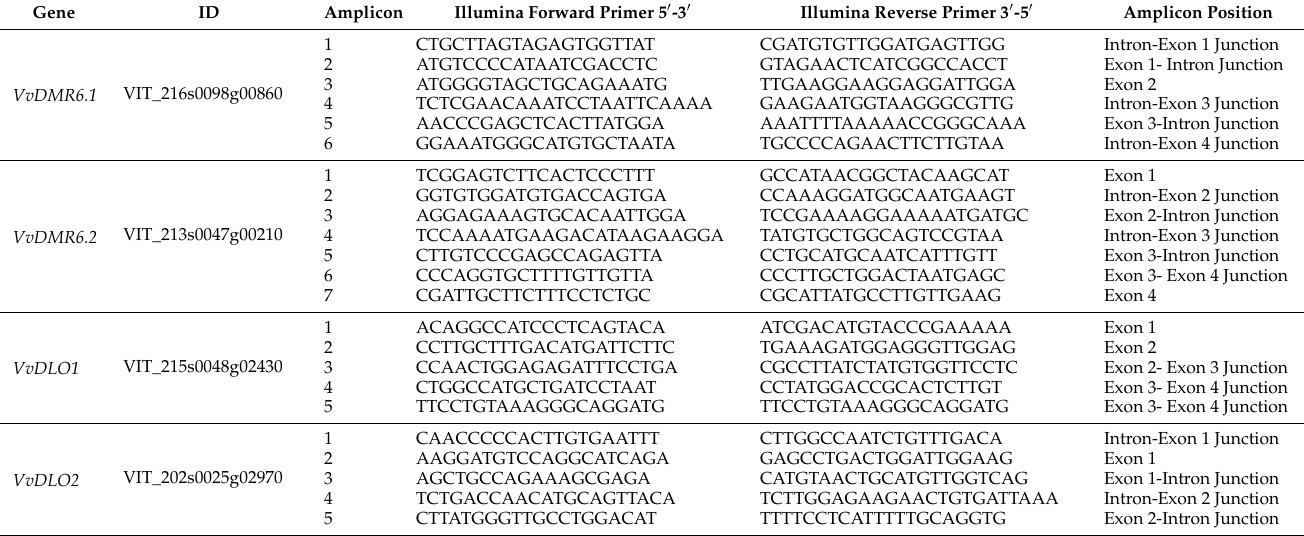
Table 1. Investigated genes with Illumina amplicon primers and